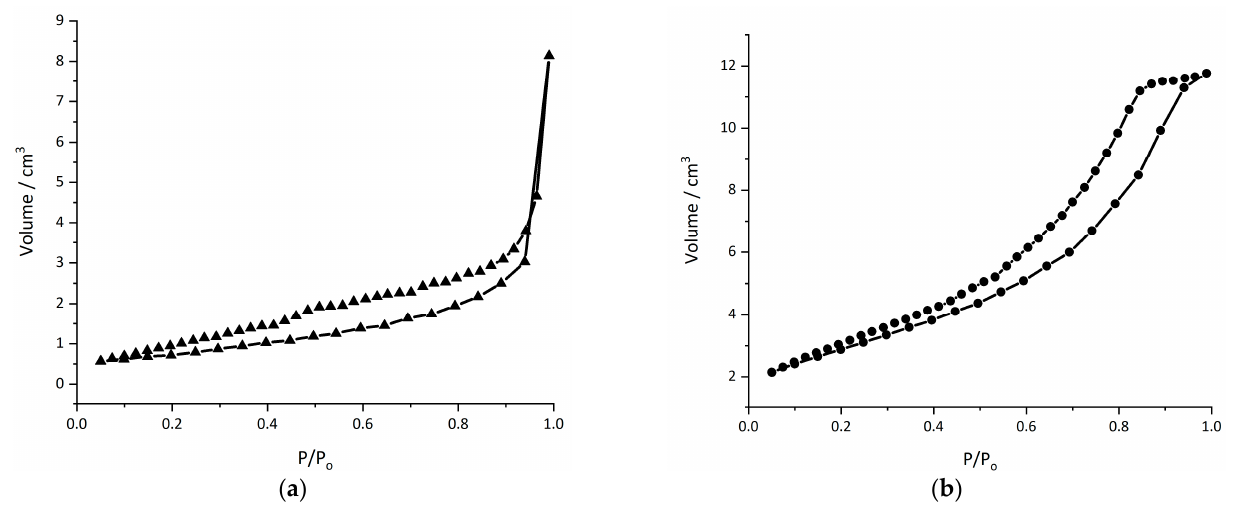
Figure 3. N 2 Adsorption–desorption isotherms of ( a ) CeO2 (IV) and ( b ) CeO2 (III) catalysts.